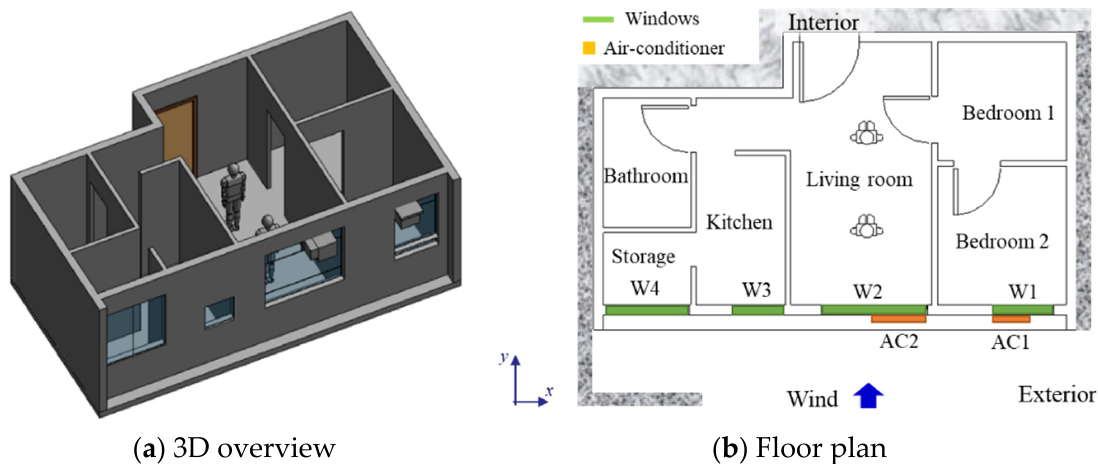
Figure 2. ( a ) The 3D overview and ( b ) floor plan for the parametric model used in analysis. Table 2. Configurations of windows in design BIM model.